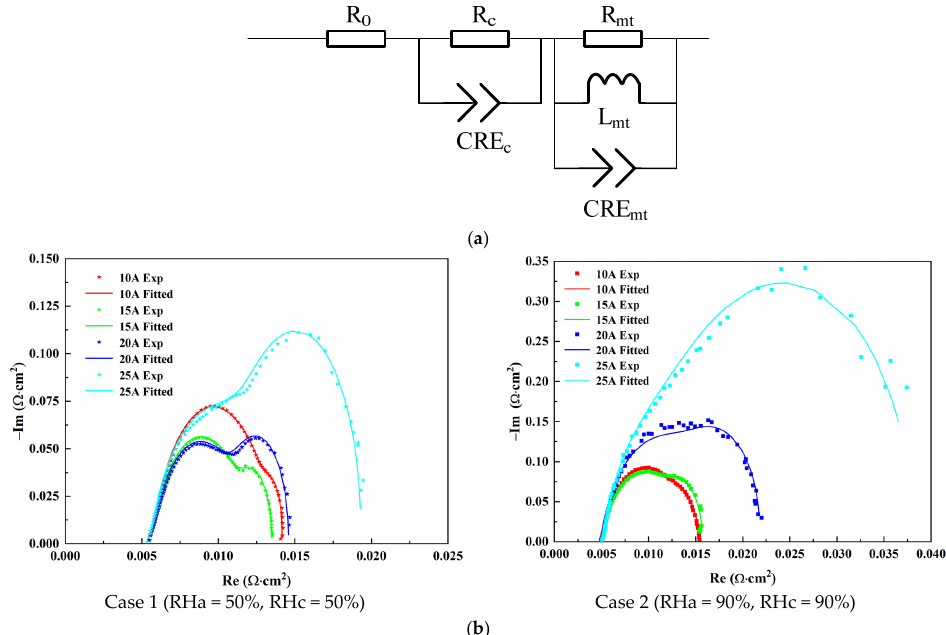
Figure 3. ( a ) Equivalent electric circuit. ( b ) Nyquist plot from the EIS measurements at various